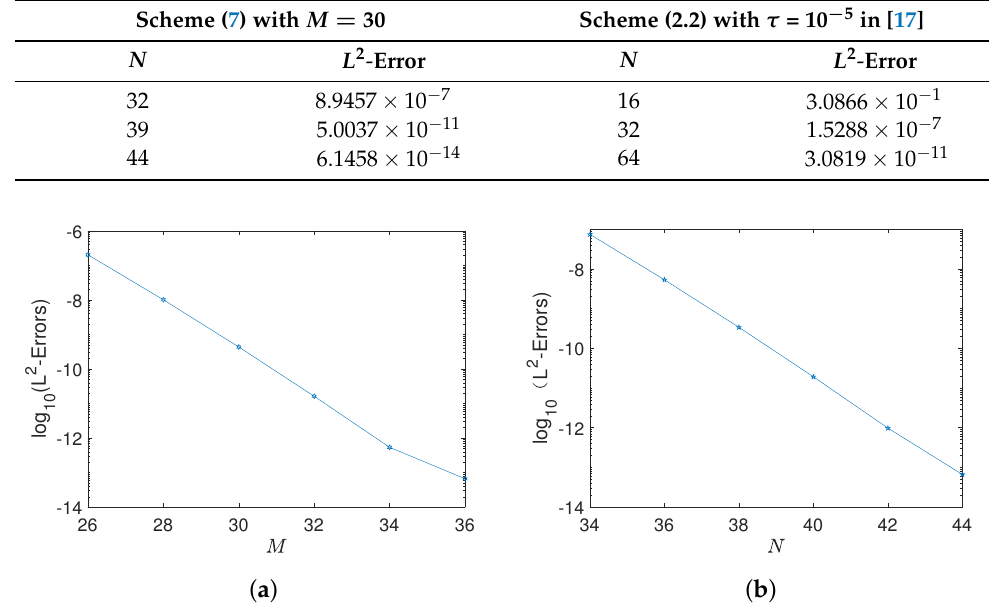
Figure 2. Spectral errors in time and space, respectively, at t = 2 for Example 1. ( a ) Temporal errors versus M with N = 50; ( b ) spatial errors versus N with M = 40.